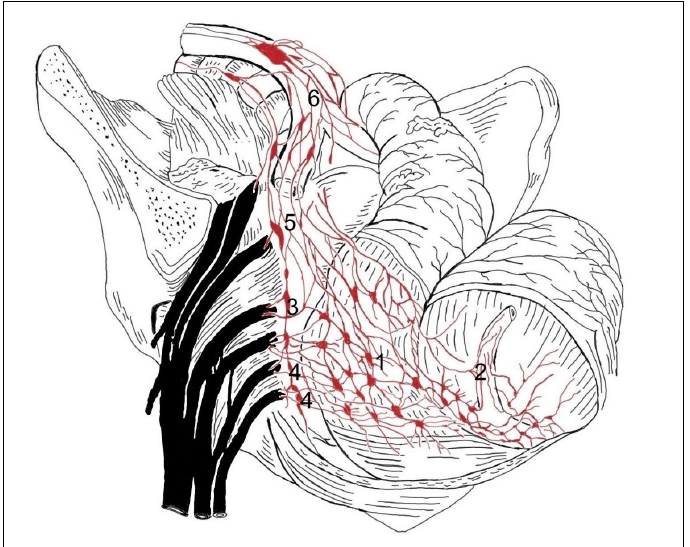
Figure 1. In the segmental type of lesser pelvic organ innervation in men, the rectal (1) and vesical (2) plexuses contain many small ganglia. Multiple connections with the sympathetic trunk are present (3). Nn. erigentes (pelvici) form connections with branches of the sacral plexus (4), which are also numerous. The inferior hypogastric plexus (5) consists of multiple nerve branches arising from the superior hypogastric plexus (6).